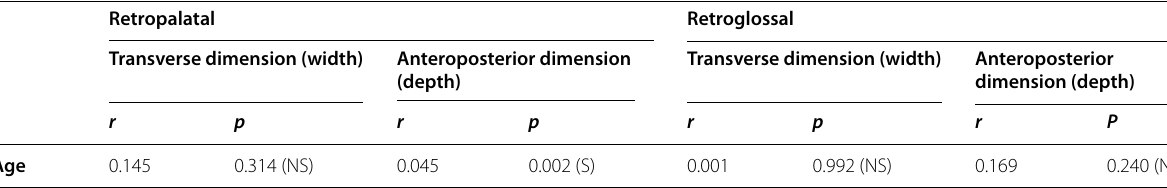
CT Computed tomography, NS